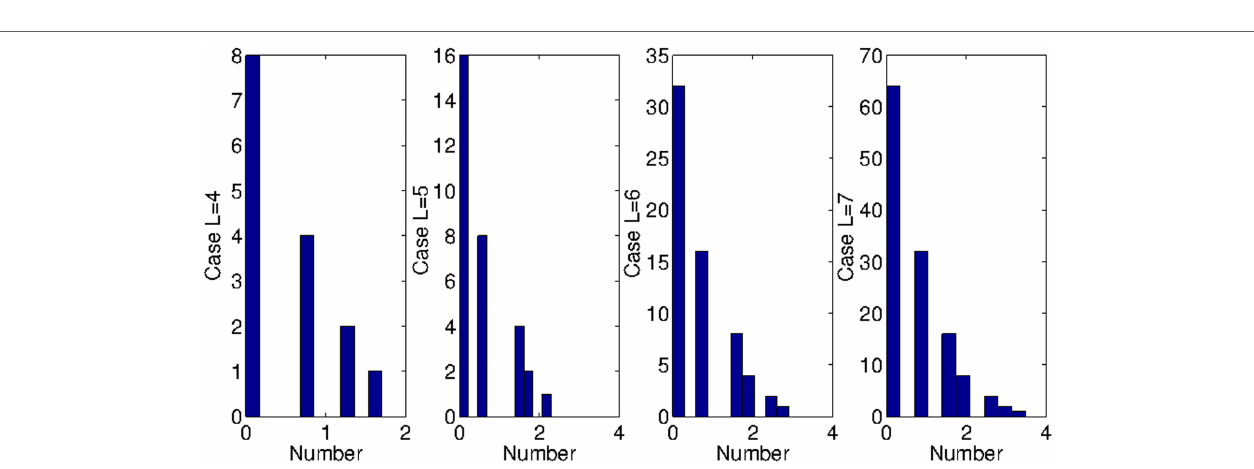
FIGURE 5 | Histograms of the asymptotic entropy values for L =4, 5, 6, 7 . We observe that the maximum entropy increases, and that the number of values on each level grows as 2 L .